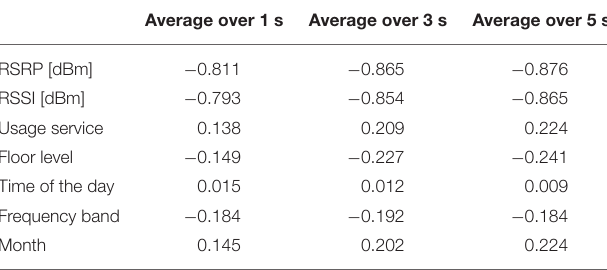
FIGURE 4 | Statistical correlation between Tx power and RSRP. TABLE 2 | Pearson correlation coefficient between inputs and target TX power for different averaging durations.